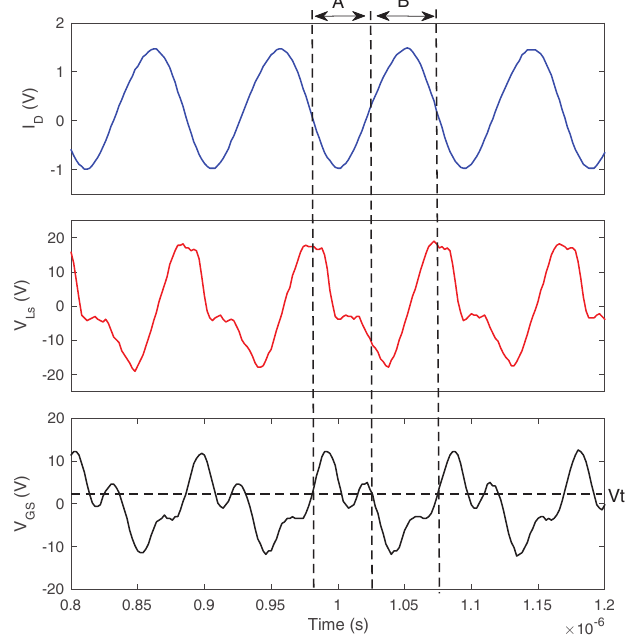
Figure 4. The type I oscillation waveforms of I D , V GS , and V Ls (Polarities defined in Figure